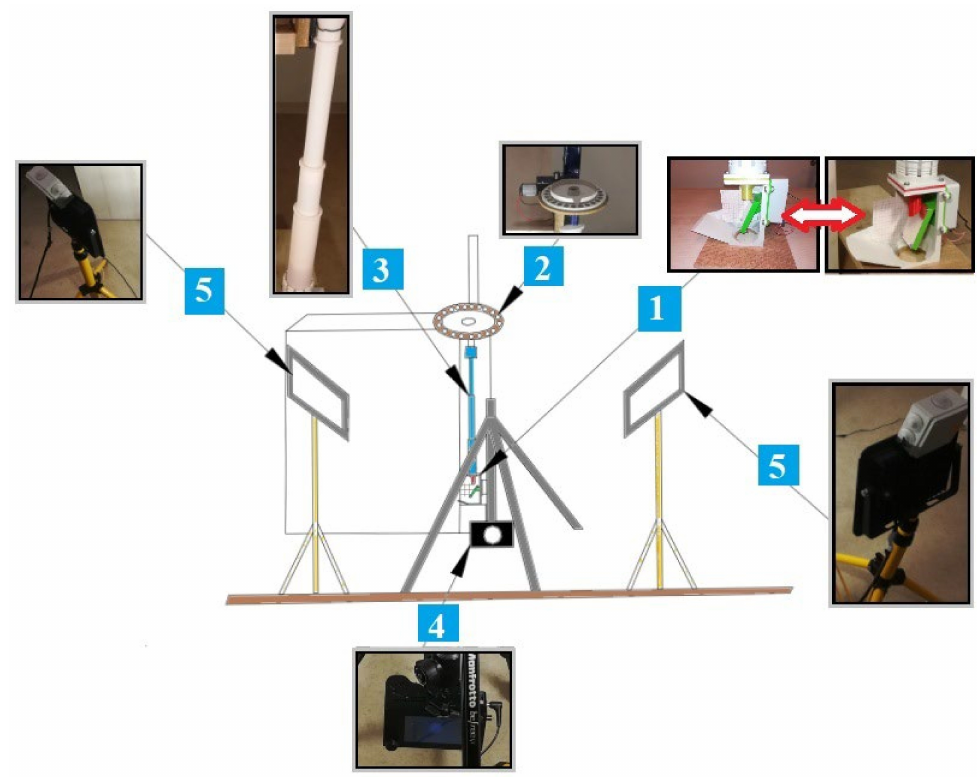
Figure 4. Scheme of a laboratory station for tests of the piezoelectric sensor PZT (ceramic): 1. Casing of sensor enabling adjustment of the seed delivery tube tilt angle, 2. Seed dispenser- in the form of a plate with holes, 3. Telescope seed delivery tube (length 65 cm), 4. Fast video camera, 5. Dedicated lighting 2 psc. LED lamp with a stabilization